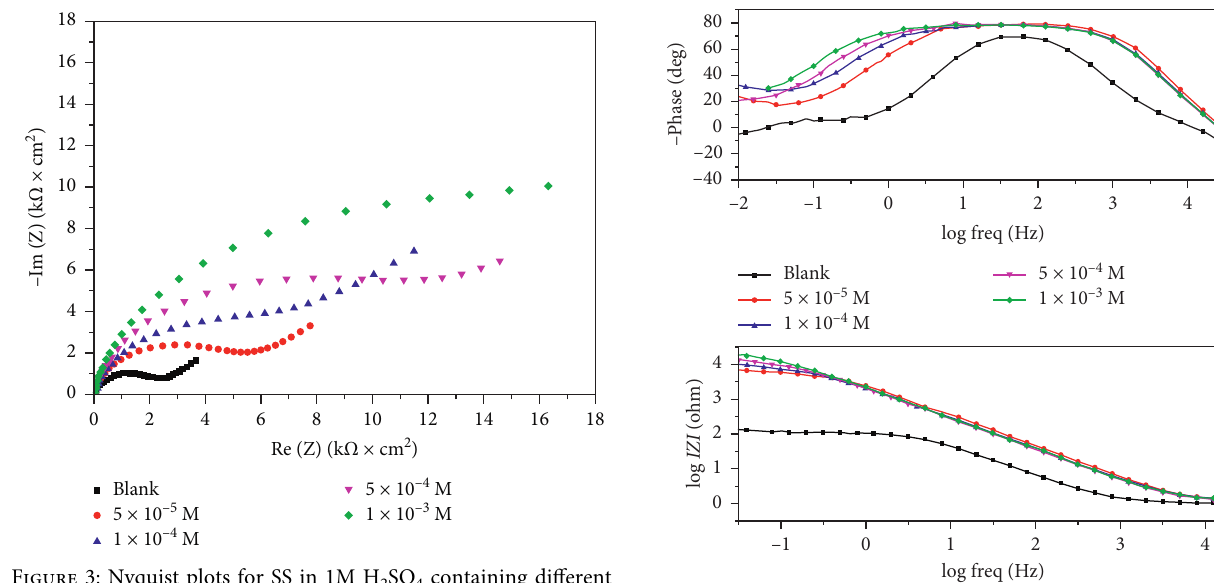
Figure 4: Bode diagram for SS in 1M H 2 SO 4 containing different presence of different concentrations of ACM at 293K.